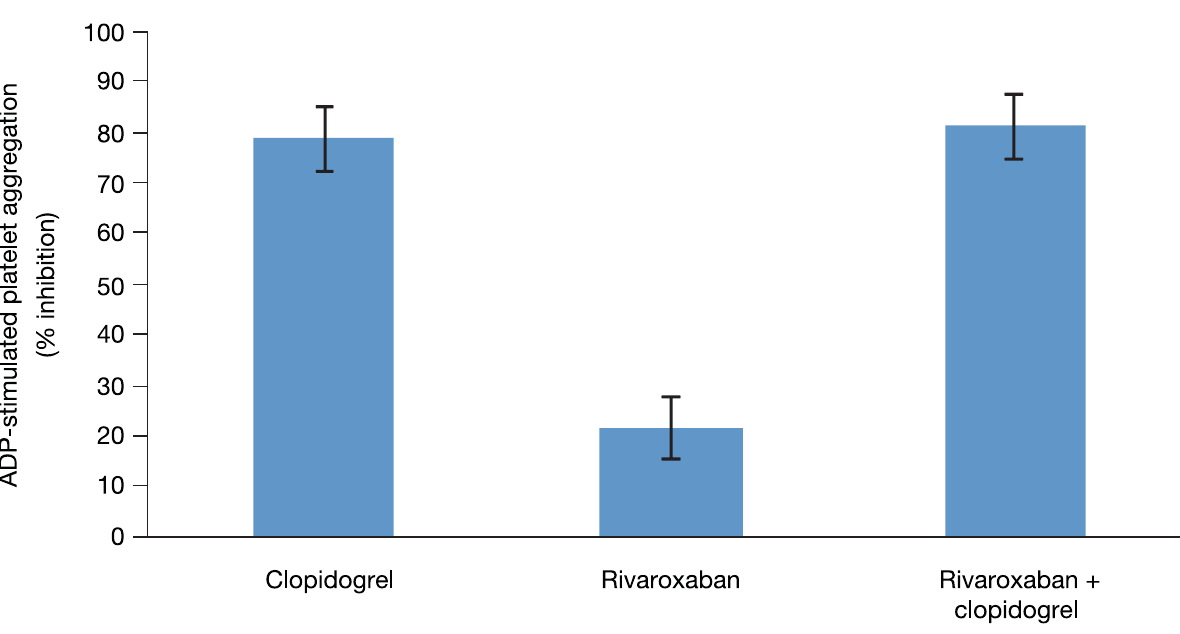
Figure 4. Platelet aggregation. The effect of clopidogrel and rivaroxaban alone and in combination on 29 µM ADP-stimulated platelet aggregation. Least squares-mean values of the percent inhibition and 2-sided 90% confidence intervals are shown, as assessed by the ANOVA method.